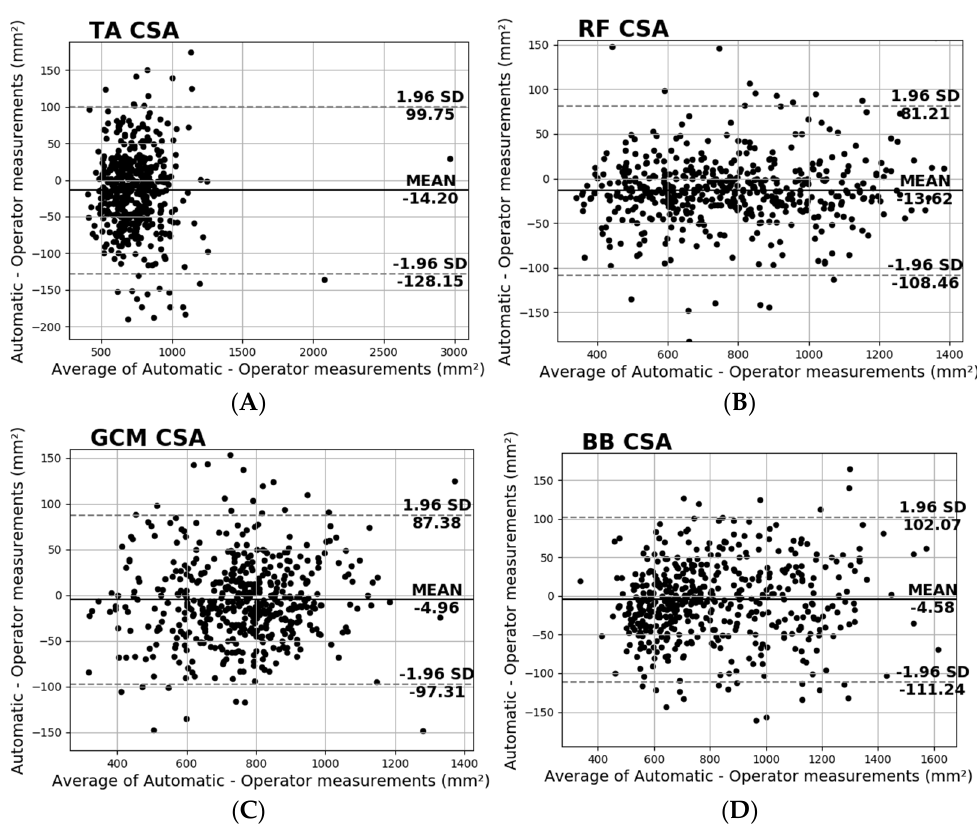
Figure 10. Bland − Altman plots of the CSA for the ( A ) T.A., ( B ) R.F., ( C ) GCM, and ( D ) B.B.